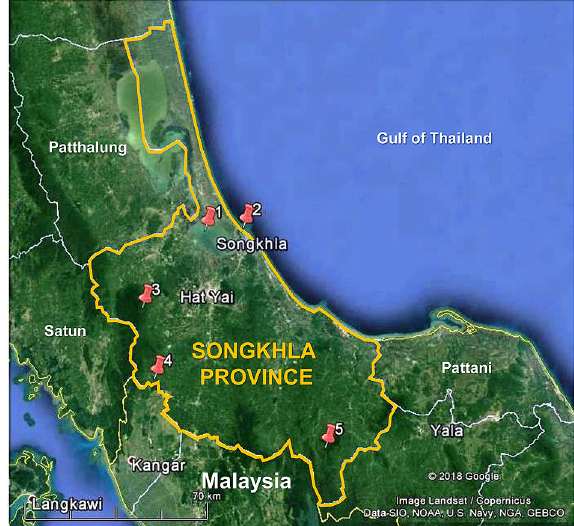
Fig. 3. Location map of selected geosites in Songkhla Province, Southern Thailand (plotted on the Google Earth).